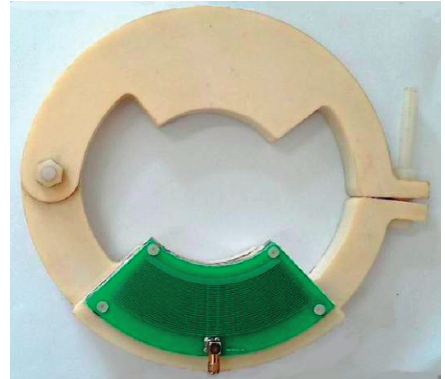
Figure 3. Open D-dot